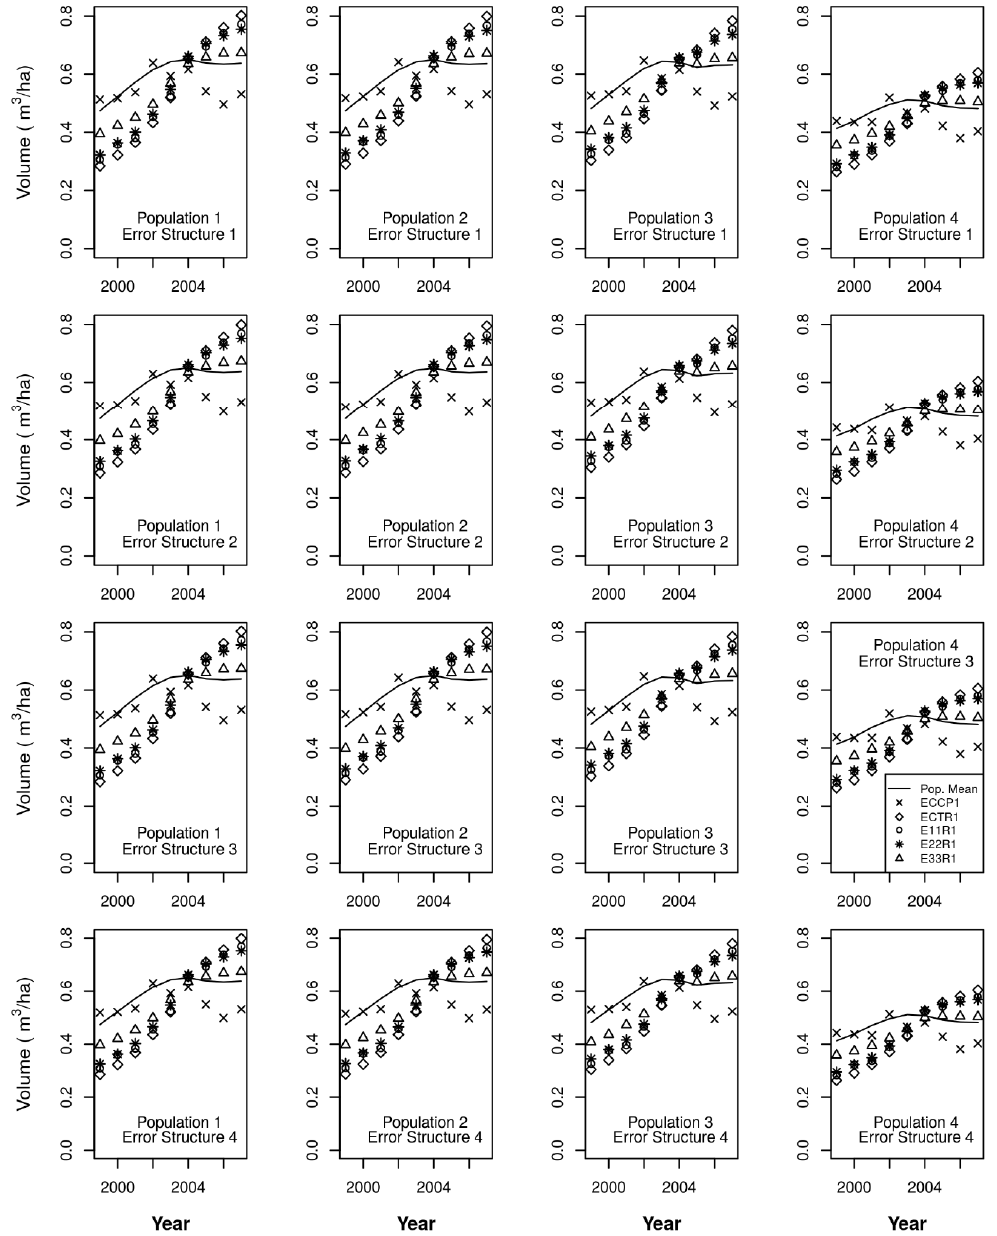
Figure 2. The means of five entry estimators including the centralized mean (ECCP1), the trend ‐ distributed estimator (ECTR1), and the three ICE ‐ enhanced estimators under availability levels A1, A2, and A3 relative to the population mean for entry, over 1000 iterations of 1000 samples for each population and sample error structure.